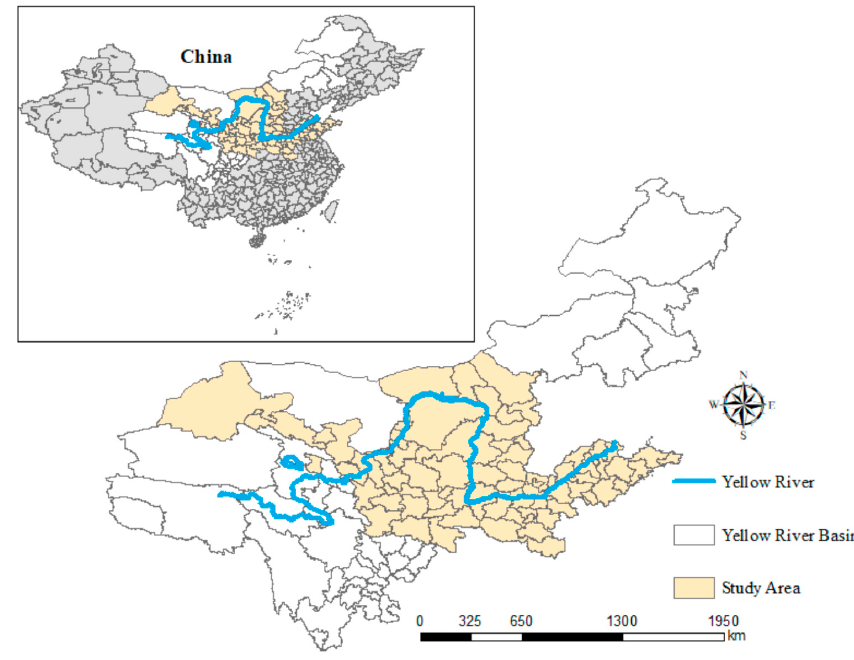
Figure 1. Map of the study area.